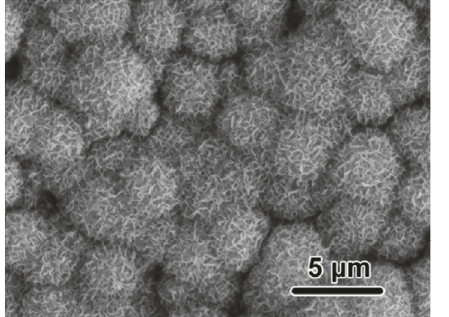
Figure 8: Surface morphology of coated specimens after being immersed in SBF for 2 weeks.